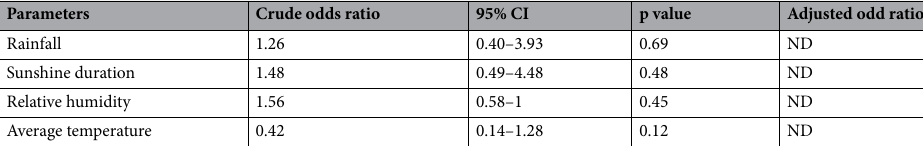
Table 4. Univariates and multivariable logistic regression demonstrate association between D. immitis infection and environment parameters. ND not determined, *p > 0.20.